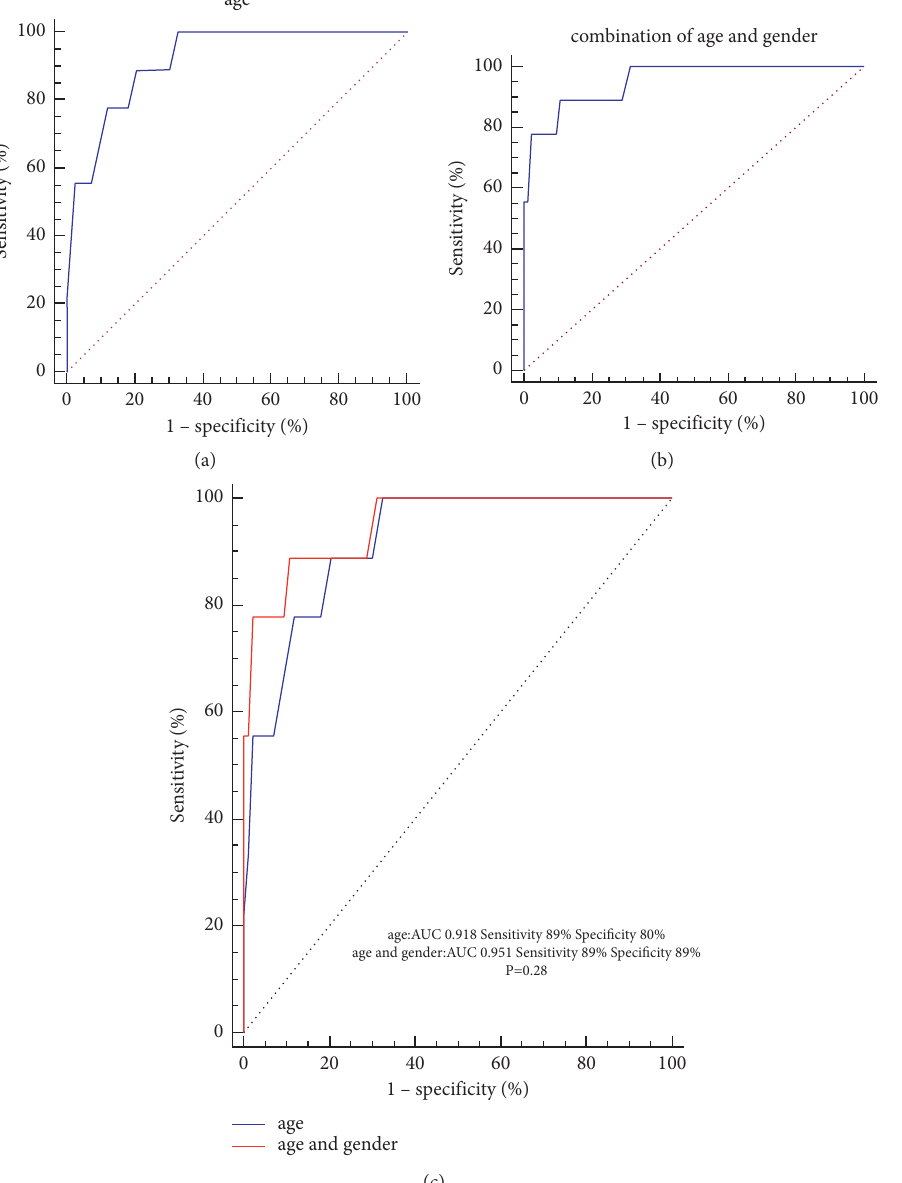
Figure 5: The receiver operating characteristic (ROC) analysis of age and combination of gender and age for predicting the LAMRT originating from the LAAW. The area under the curve (AUC) of age and combination of gender (and age for predicting the LAMRT originating from the LAAW) were 0.918 (a) and 0.951 (b), respectively. (c) Although the comparison between the two was not statistically significant, the combination of gender and age showed a higher specificity. LAAW: left atrial anterior wall; LAMRT: left atrial macroreentry